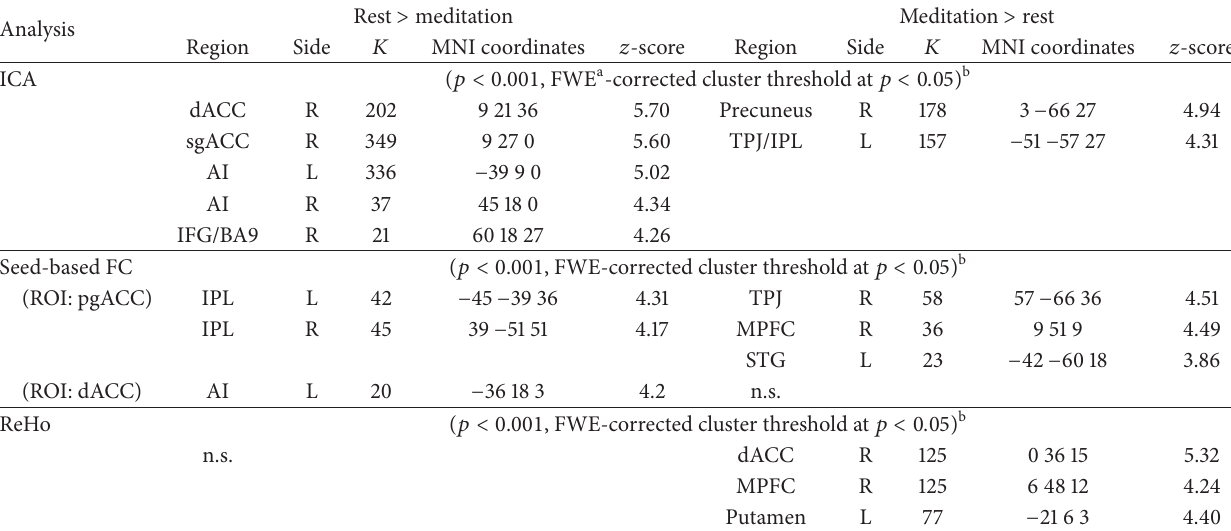
Table 3: Regions showing functional differences between conditions (rest versus meditation).